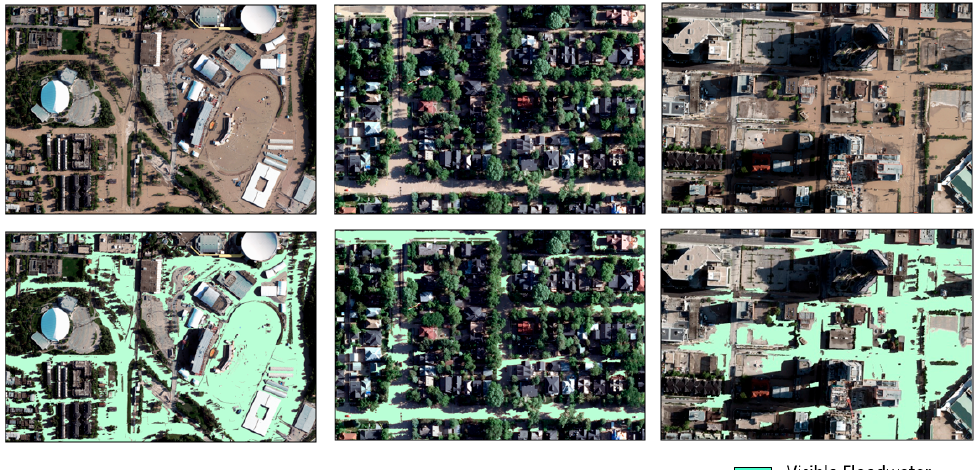
Figure 8. Selected portions of the visible floodwater map (for coverages shown in Figure 2) derived from the aerial photos over the business park (left) in site A, the maturated residential area mainly with single houses (middle) in site B, and the downtown area mainly with high- and low-rise buildings (right) in site C.